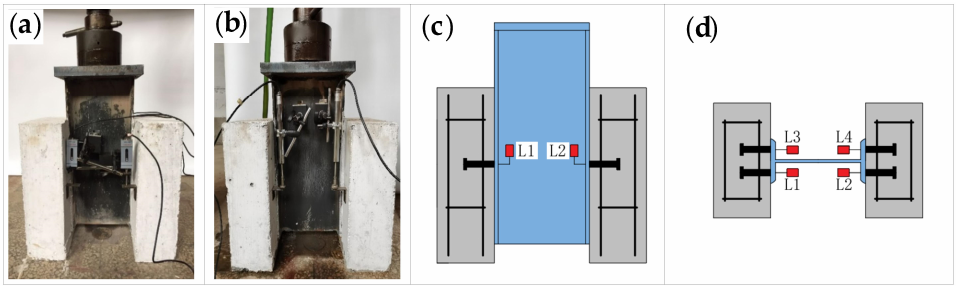
Figure 4. Arrangement of measurement points and displacement transducers: ( a ) static loading; ( b ) fatigue loading; ( c ) layout of measurement points: main view; ( d ) layout of measurement points: top view.